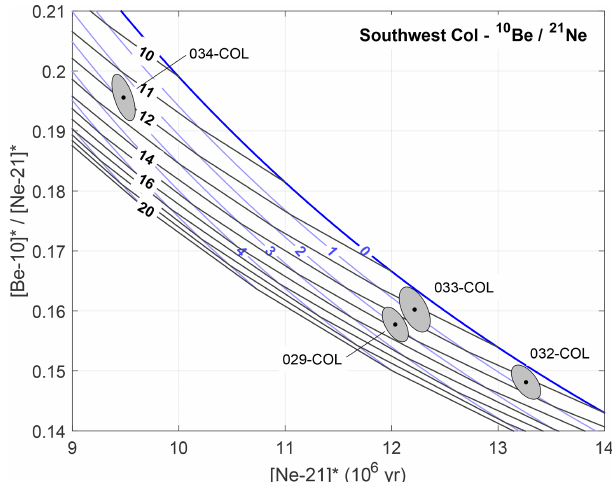
Figure 10. 10 Be– 21 Ne normalized two-nuclide diagram for South- west Col sandstone erratics. Blue lines are isolines of constant steady erosion (cmMyr − 1 ); black lines are isolines of constant ex- posure age (Myr). The diagram is constructed using LSDn produc- tion rate scaling and a 21 Ne / 10 Be production ratio of 4.03 (Balco et al., 2019). Note that the x coordinate, the 21 Ne concentration nor- malized to the production rate, is equivalent to the apparent 21 Ne exposure age. Although apparent 21 Ne exposure ages for these sam- ples are 9.5–13Myr, the two-nuclide diagram shows that the data are better explained by 12–15Ma exposure at erosion rates between 0.5 and 3cmMyr − 1